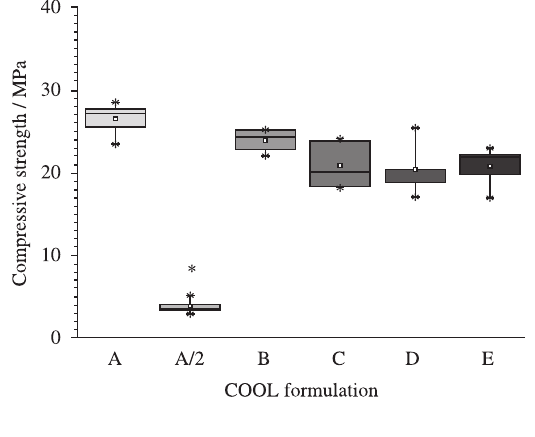
Figure 2 . Compressive strength according to ISO 5833 of different COOL formulations (mean ± SD, n = 6) measured after 48 hours (24 hours in H 37 °C, 24 hours in air at 21 °C). Statistical significant differences are marked with * for p < 0.05